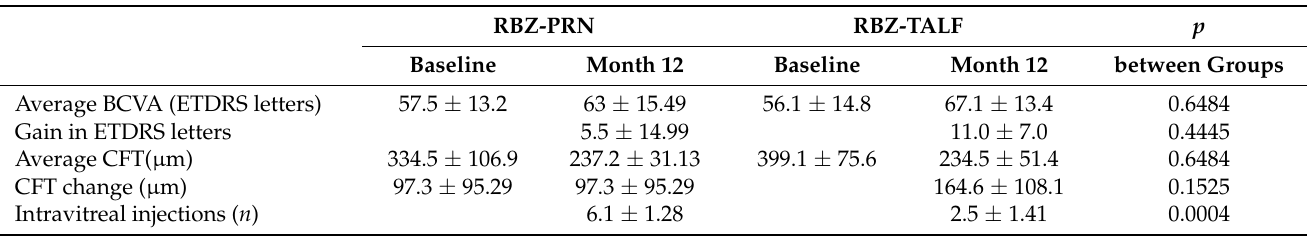
Table 3. Comparison of efficacy endpoints at the end of the follow-up period between the RBZ-PRN and RBZ-TALF groups.